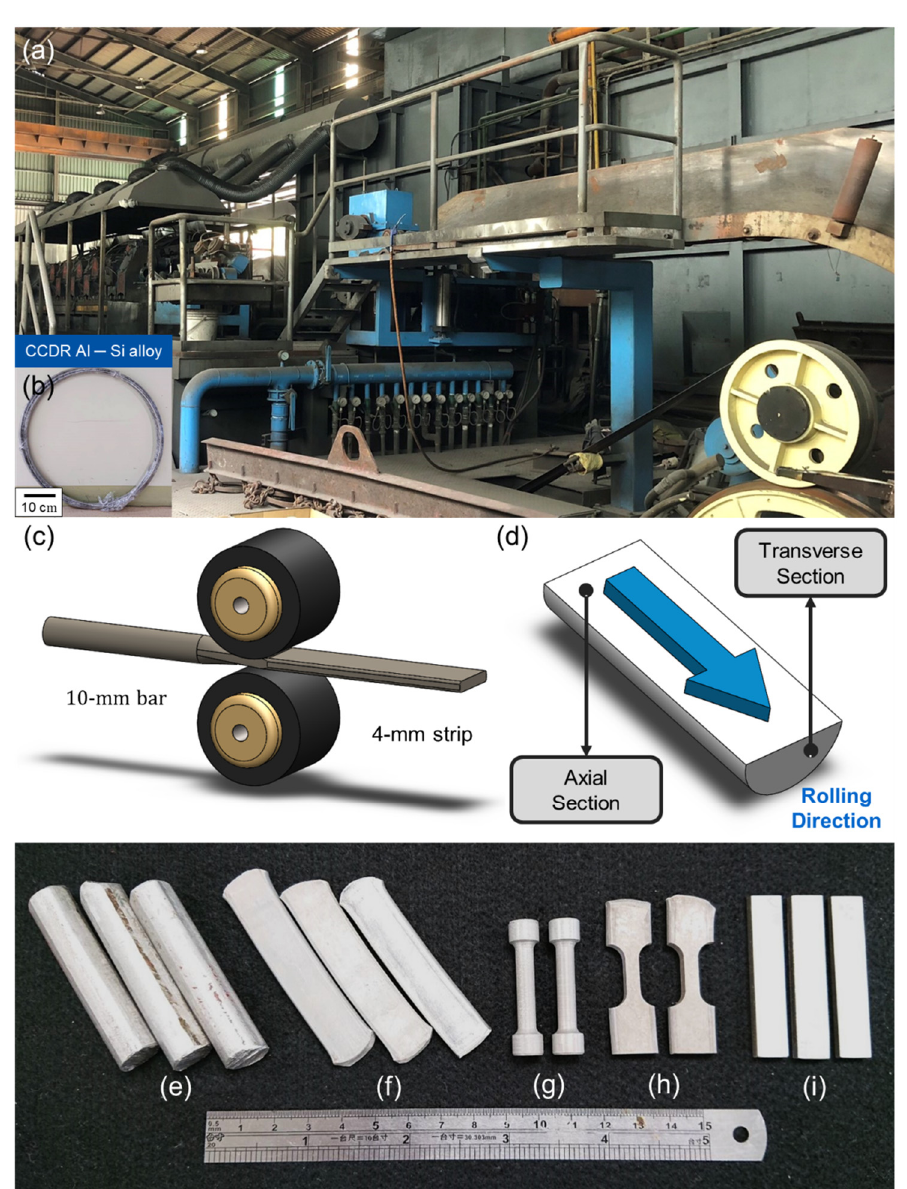
Figure 1. ( a ) Al-Si alloy CCDR equipment, ( b ) bar coil of the CCDR Al-Si alloy, ( c ) schematic diagram of the bar being cold rolled into strip, ( d ) the definition of the axial and transverse sections, ( e ) as-manufactured and ( f ) as-manufactured after rolling, ( g ) dumbbell-shaped tensile specimens, ( h ) dog-bone-shaped tensile specimens, and ( i ) specimens for erosion wear. Table 1. Chemical composition analysis of the Al–Si alloy (wt.%). Elements